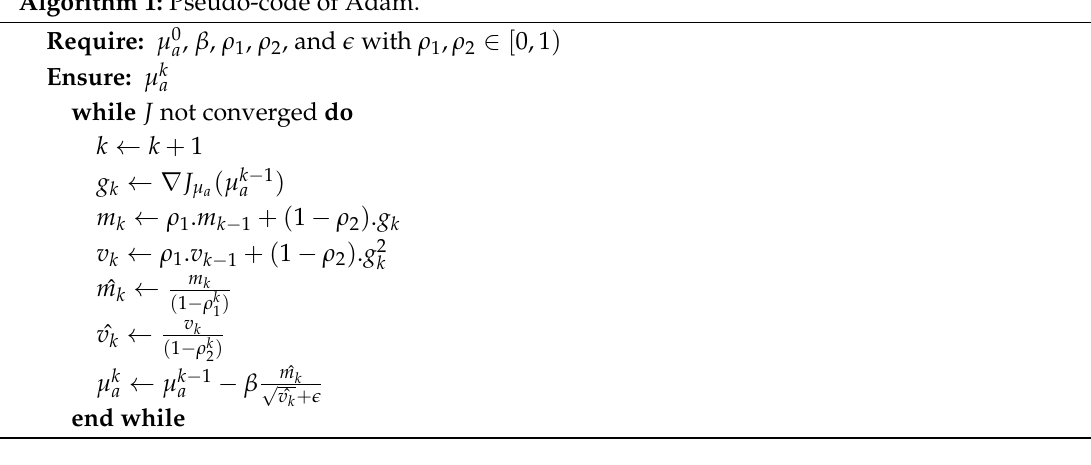
Algorithm 1: Pseudo-code of Adam.